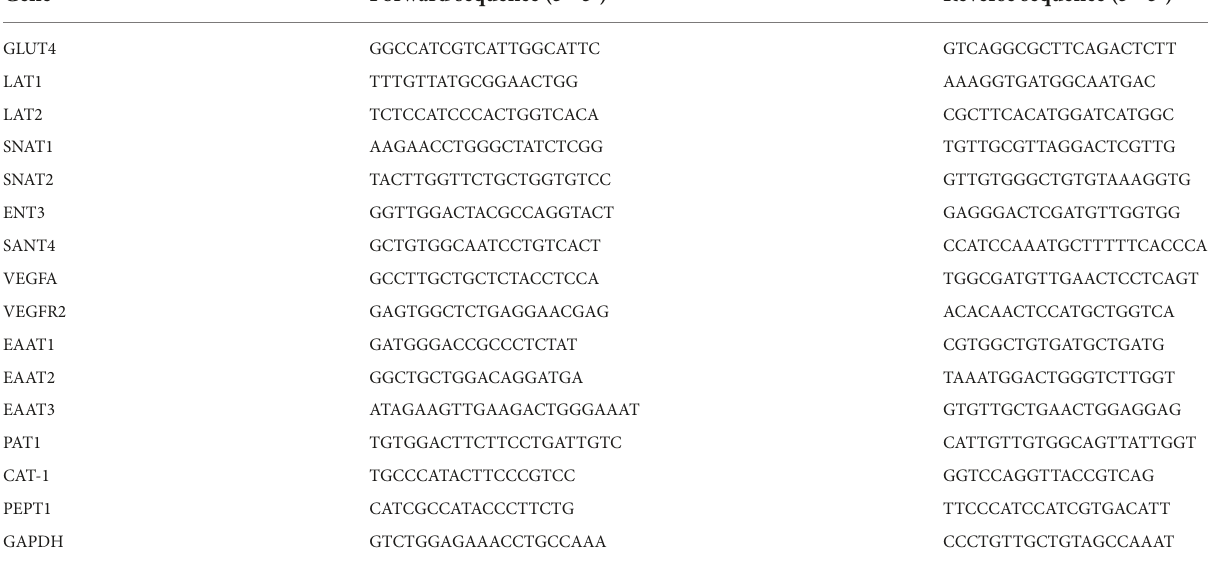
TABLE 1 Primer used for real-time PCR. Gene Forward sequence (5 (cid:48) –3 (cid:48) ) Reverse sequence (5 (cid:48) –3 (cid:48) )